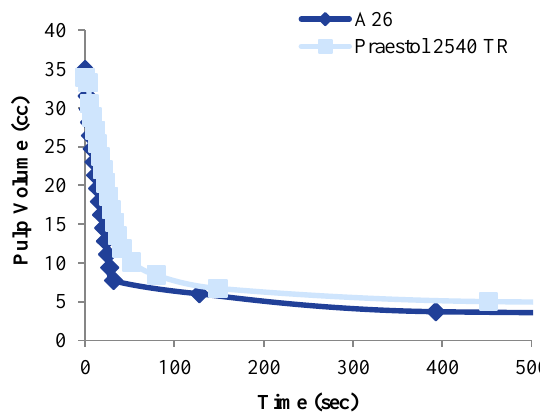
Figure 6. Settling rate of Praestol 2540 and TR A26 Resulted solids were poured in 1000 ml of water with hot flocculants mixer or hand-held devices (for an hour) and then certain amount of flocculants were added for preparation in each experiment. Graduated cylinder after 5 reverse orders was placed on a flat surface due to the low density. The height of the interface is transparent to pulp (flower bottom line is for every 50 ml) that was record settling time. The main characteristic of these curves is that each of them begins with a straight line, then it becomes a curve parallel to the time axis. Tangent drawn at any point on the curves, which present the rate of the solid- liquid, interfaces deposition of solids in the vicinity of the yielded point. Thus, high and uniform deposition rate initially becomes less and less frequently in next steps. Reduction